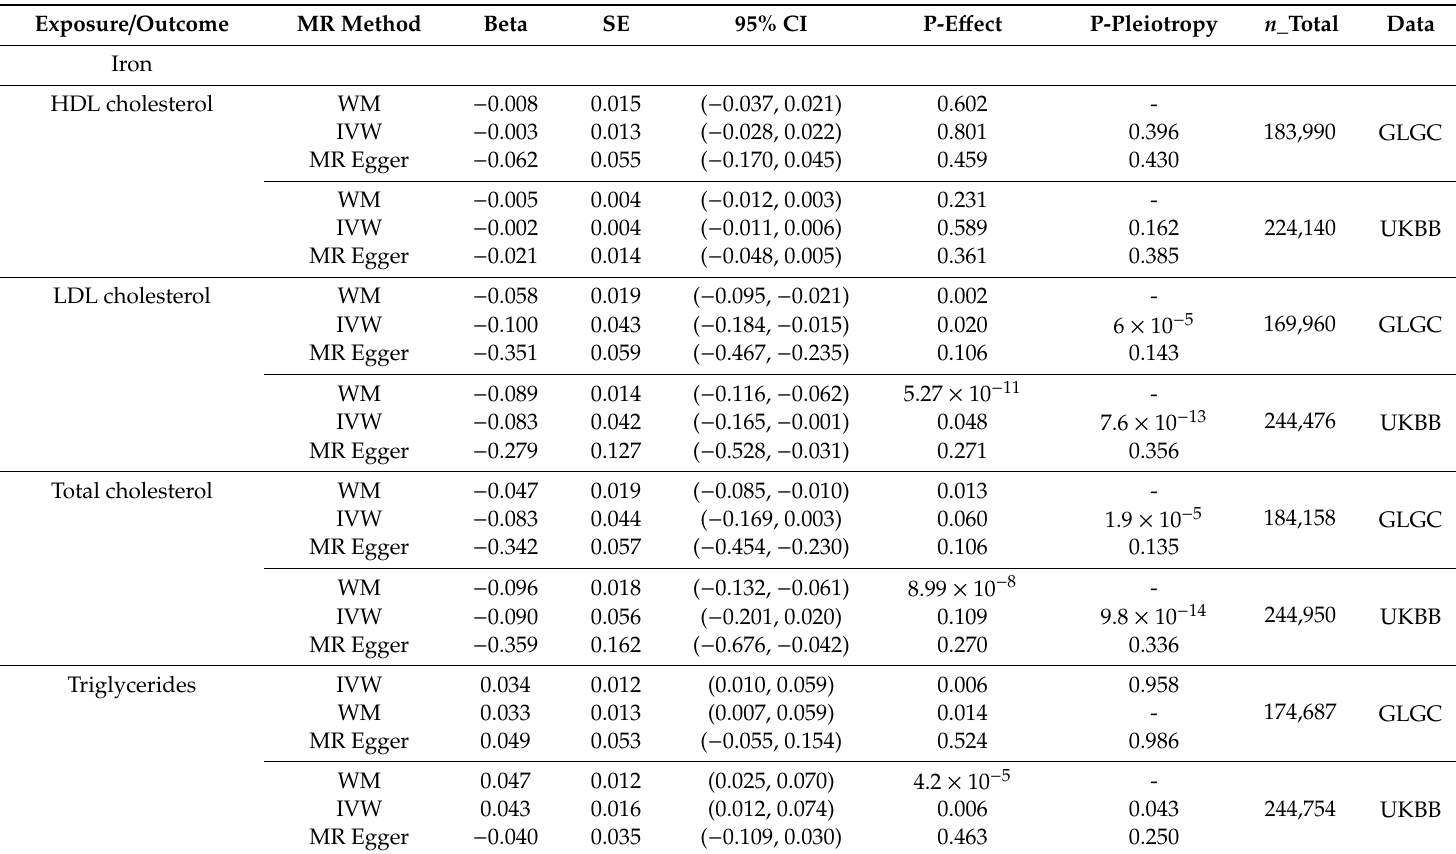
Table 2. MR analyses of iron and copper on blood lipids (mmol / L) in UK Biobank (UKBB) and Global Lipids Genetics Consortium (GLGC). Exposure /